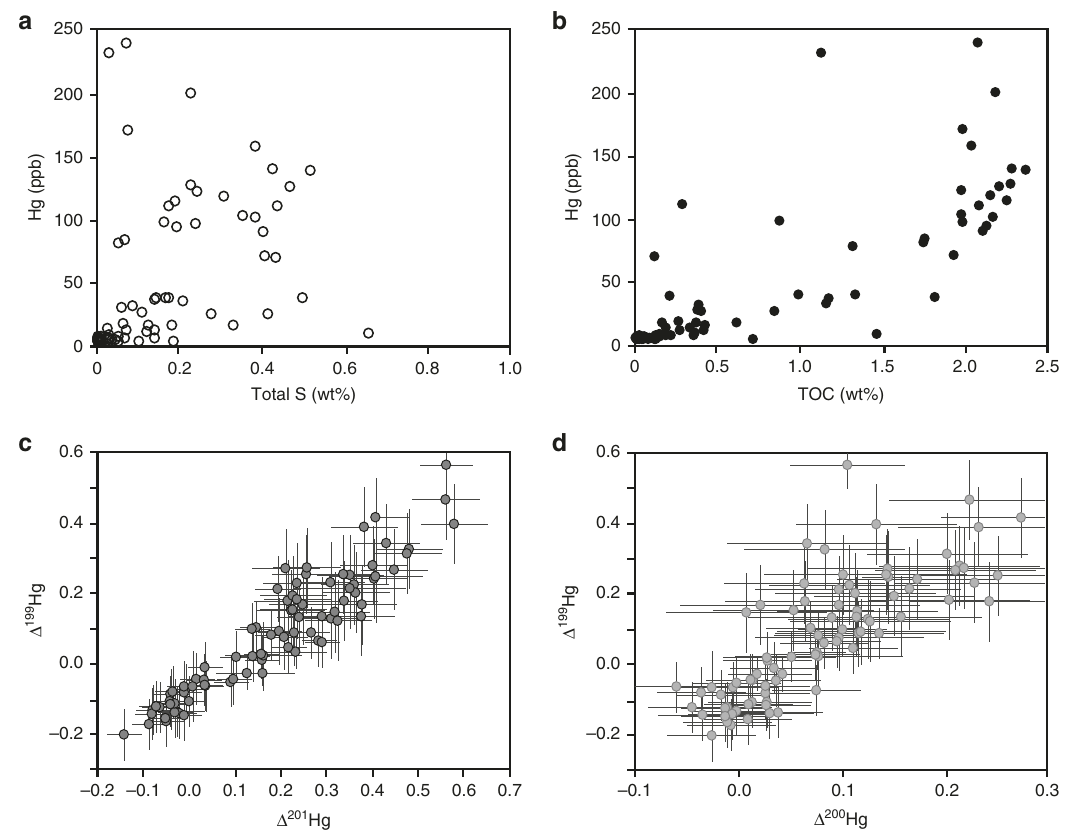
Fig. 2 Cross plots of geochemical data. Uncertainties on Hg isotope data correspond to the larger value of either the measurement uncertainty of replicate digests of MESS-2 or the uncertainty of repeated measurements of UM-Almadén; analytical uncertainties for additional data are encompassed within each individual data point. These plots demonstrate a lack of correlation between Hg (ppb) and total sulfur content (S wt%) ( a ), and generally positive correlations between Hg (ppb) and total organic carbon (TOC, wt%) ( b ), Δ 199 Hg and Δ 201 Hg (both in ‰ ) ( c ), and Δ 199 Hg and Δ 200 Hg (both in ‰ ) ( d